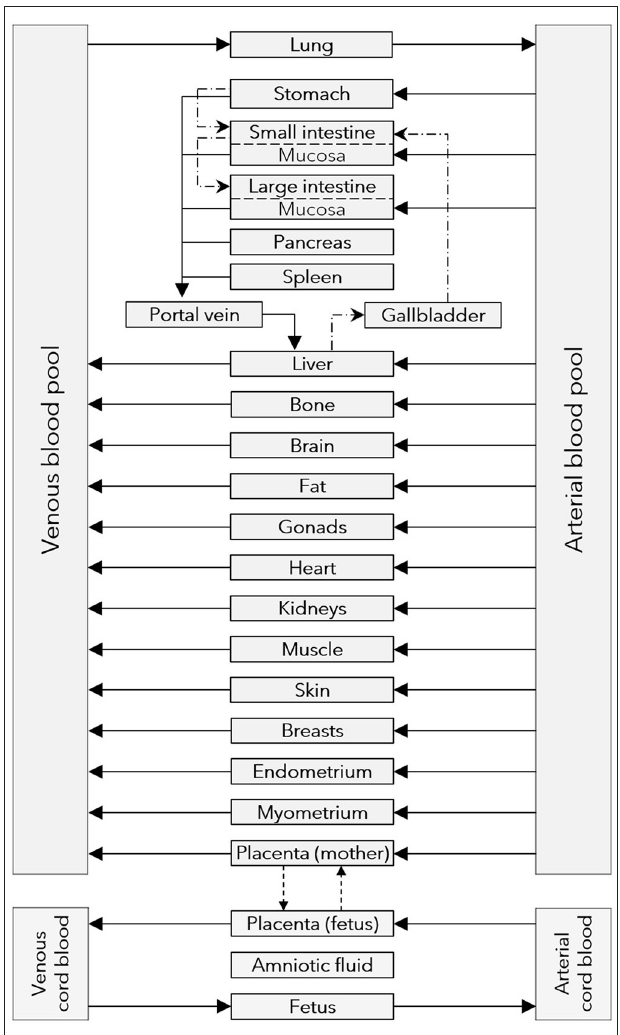
FIGURE 1 | Structure of the maternal-fetal PBPK model. Gray boxes represent compartments of the physiologically based pharmacokinetic (PBPK) model; solid arrows denote drug transport via the organ blood flow; dashed arrows denote drug transport via passive diffusion; dash dotted lines denote drug transport via gastrointestinal motility or the biliary excretion